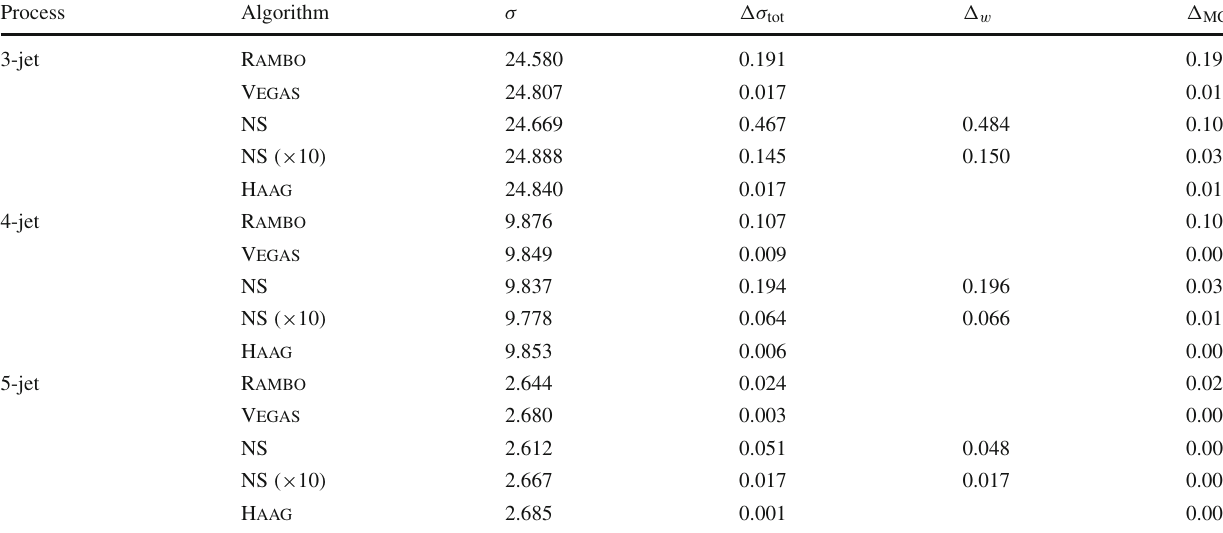
Table 4 Comparison of integrals calculated for the three-, four- and five-gluon processes using R AMBO , V EGAS , NS and H AAG , along with the respective uncertainties Process Algorithm